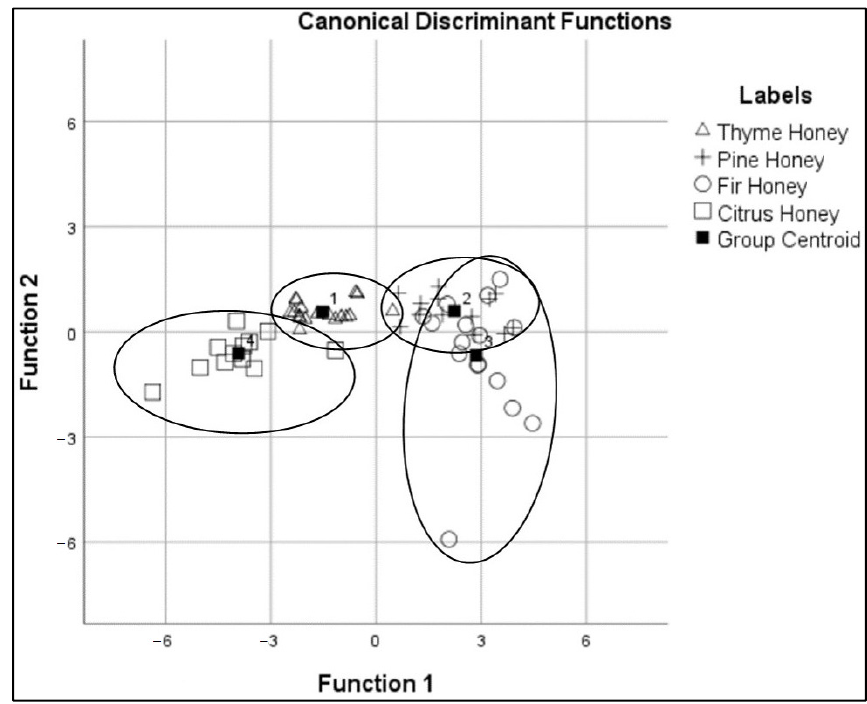
Figure 9. Discrimination results based on λ ex = 360 nm. Group centroids of pine and fir honey failed to display the same clear separation as was evident between the thyme and citrus honey. Specifically, the rate of samples that were classified correctly was 81.4%, while cross-validation was 79.7%. The statistical test of Λ